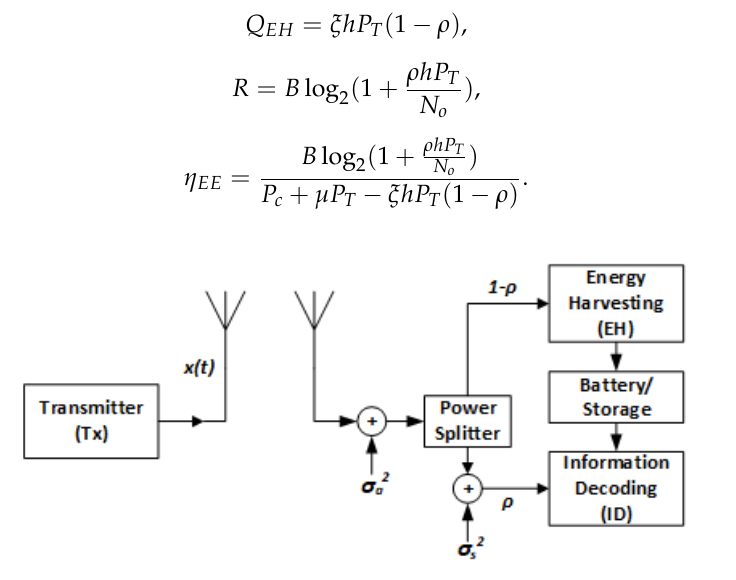
Figure 2. SWIPT power splitting (PS)